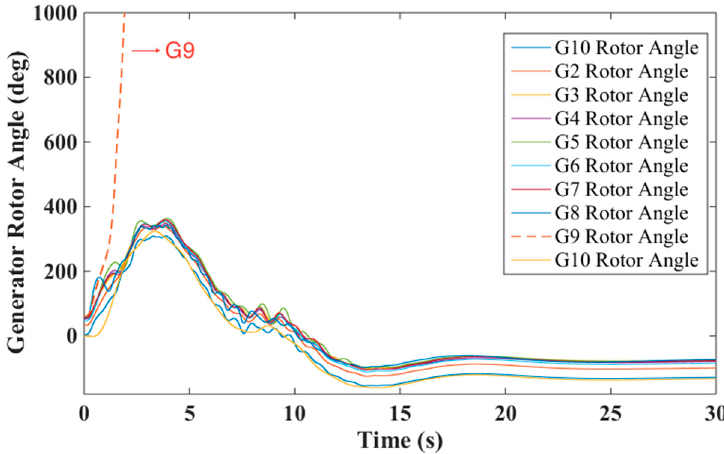
Figure 2. Voltage sags at buses 26, 28, and 29.